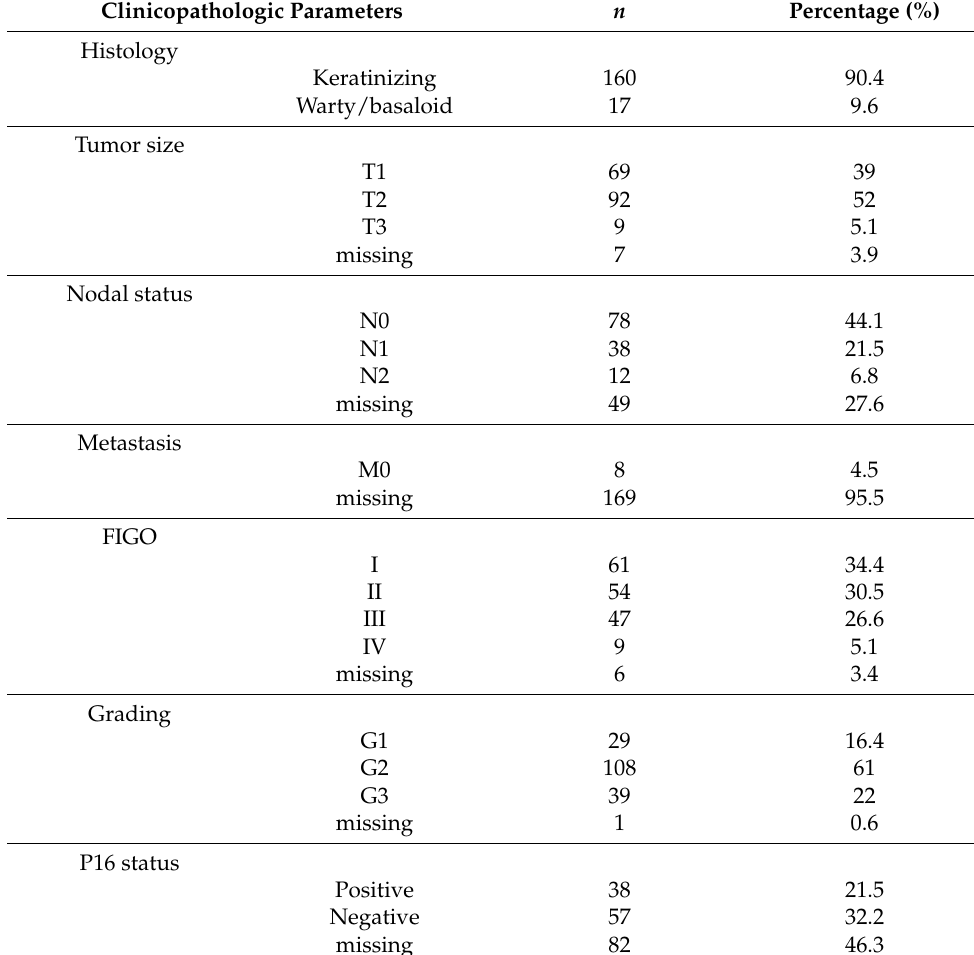
Table 1. Clinicopathological characteristics of the analyzed vulvar carcinoma